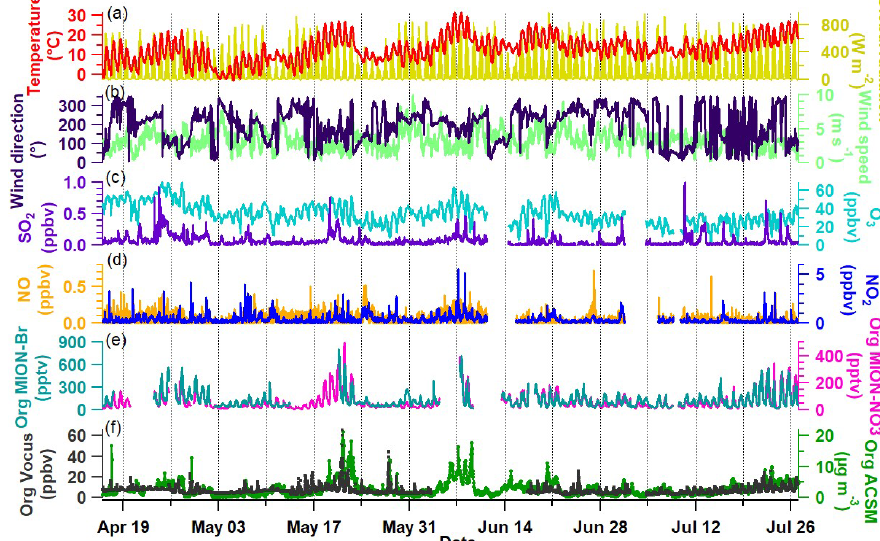
Figure 1. Overview of the time series from 16 April to 26 July 2019. (a) Temperature and global radiation; (b) wind direction and wind speed; (c) mixing ratios of SO 2 and O 3 ; (d) mixing ratios of NO and NO 2 ; (e) total gaseous organics measured by MION-Br and MION-NO 3 ; and (f) total gaseous organics measured by Vocus as well as total particulate organics measured by ACSM. The data gap between MION-Br and MION-NO 3 (e.g., around 17 May) was due to the fact that the MION API-ToF was only running with API mode and NO 3 mode because of a mass flow controller issue for Br mode at that time.